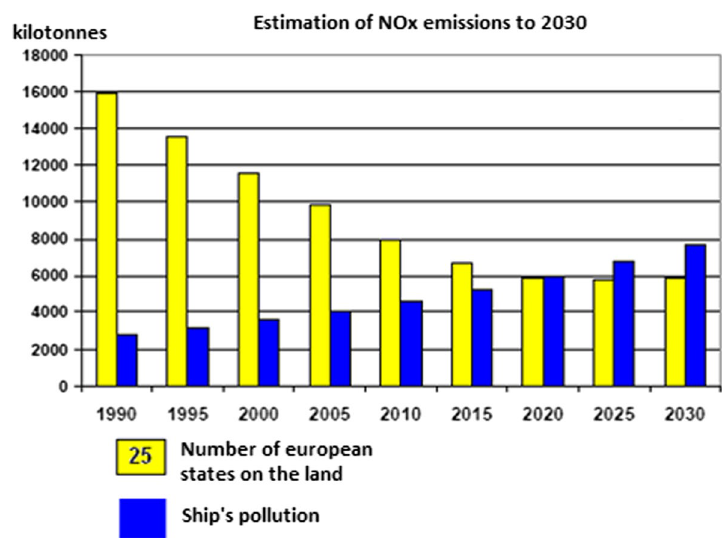
Fig. 1 An estimation of NOx emissions to 2030 (Grosan 2011)